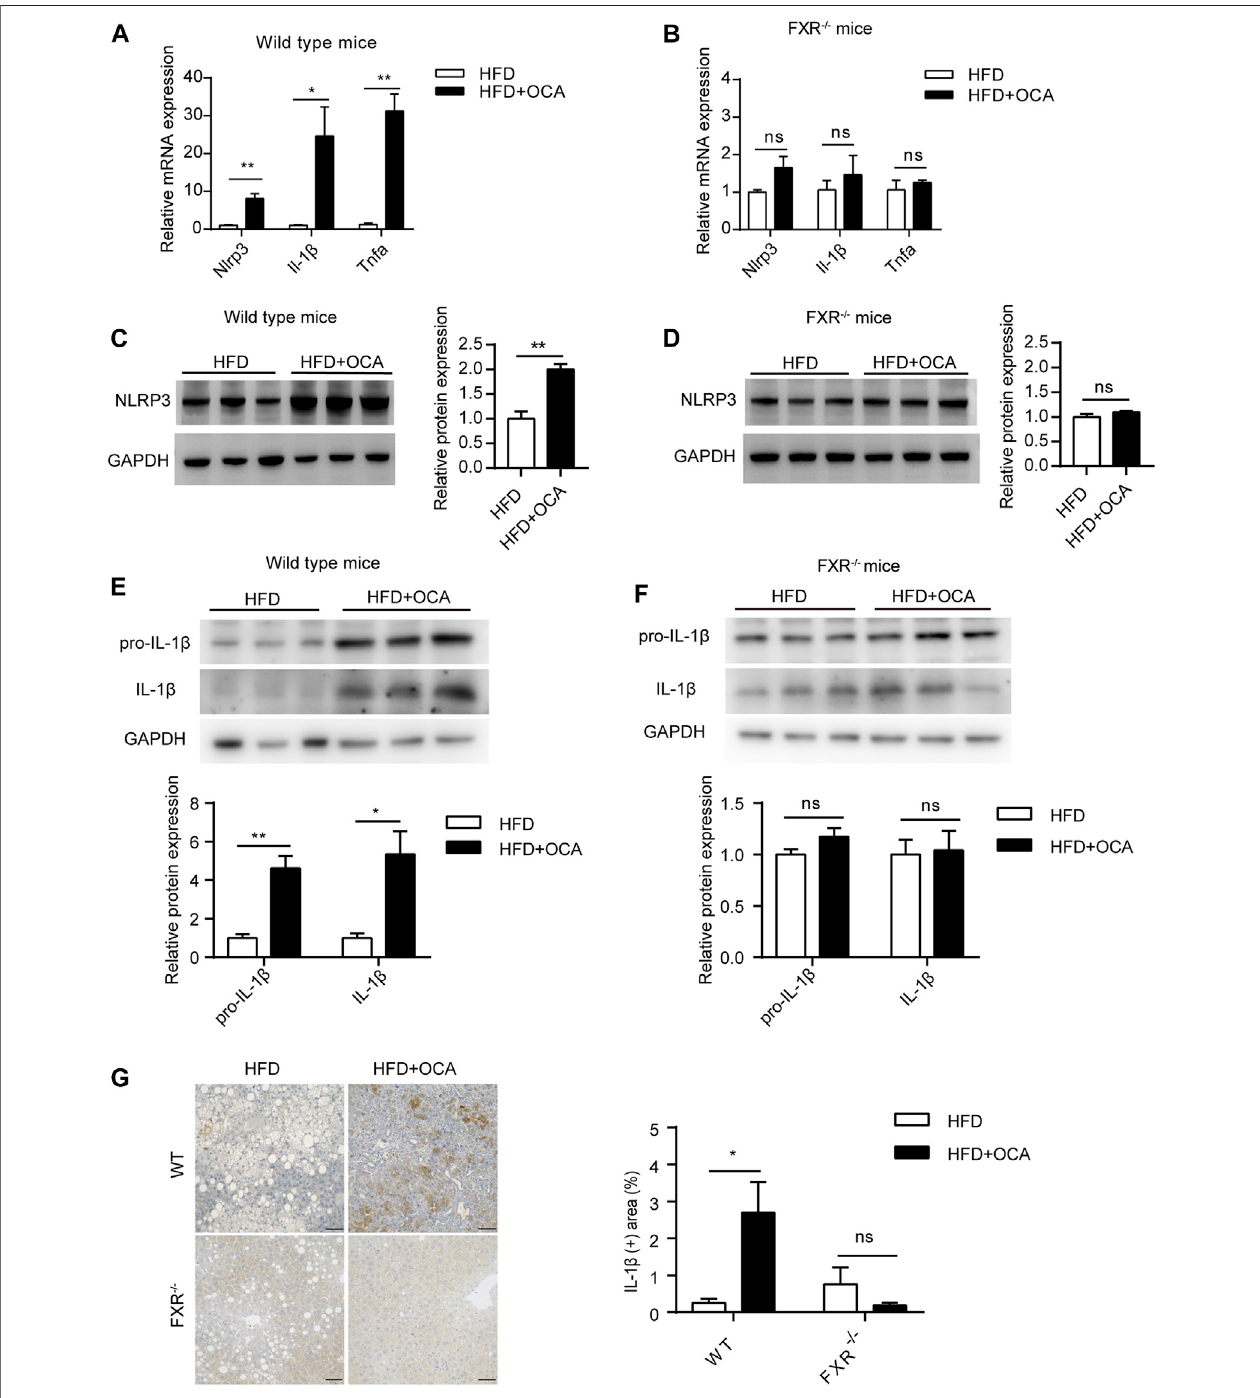
FIGURE4| High-dose OCAupregulatedIL-1 β dependentofFXR. (A) RelativemRNAexpressionofNlrp3,Il-1 β ,andTnf α wasdetermined byquantitativereal-time PCR (qPCR) in wild type mice. (B) Relative mRNA expression was determined by qPCR in FXR − / − mice. (C) Protein expression of NLRP3 in WT group. (D) Protein expression of NLRP3 in FXR − / − mice. (E) Protein expression of IL-1 β in WT group. (F) Protein expression of IL-1 β in FXR − / − mice. (G) Immunohistochemistry for IL-1 β in the liver of the mice. (Scale bars, 50 μ m). OCA, obeticholic acid; ns, not signi fi cant; *, p ＜ 0.05; **, p ＜ 0.01; ***, p ＜ 0.001.